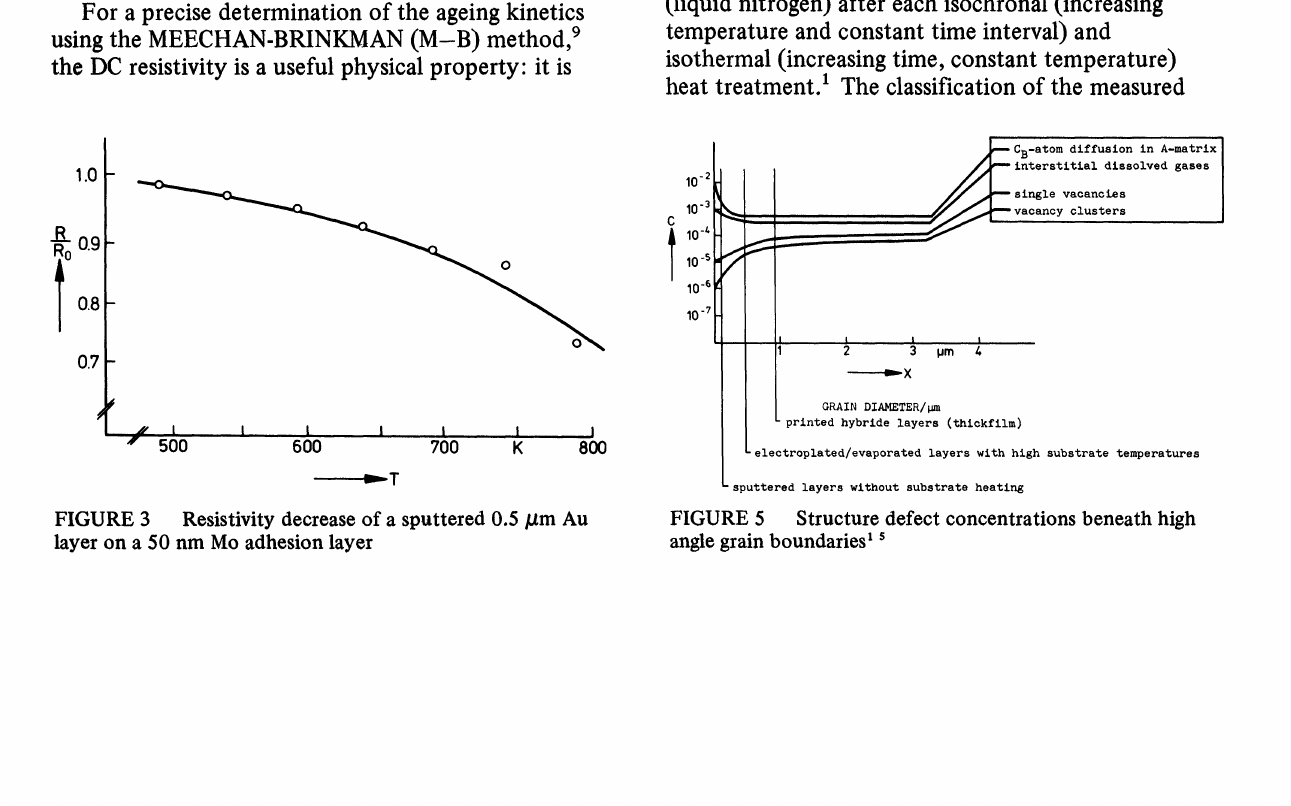
Resistivity change of an evaporated 5/am Au layer o measured values the grain coarsening of thin Au layers (right scale) === resistivity decrease due to recovery ’ resistivity increase due to Cr diffusion into the Au